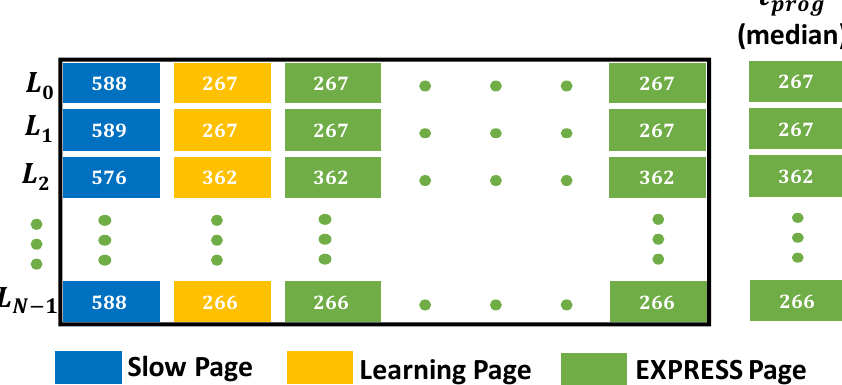
Figure 10. Classification of different SLC pages of the same memory block. The numbers represent measured t prog values in µ s corresponding to the page location.